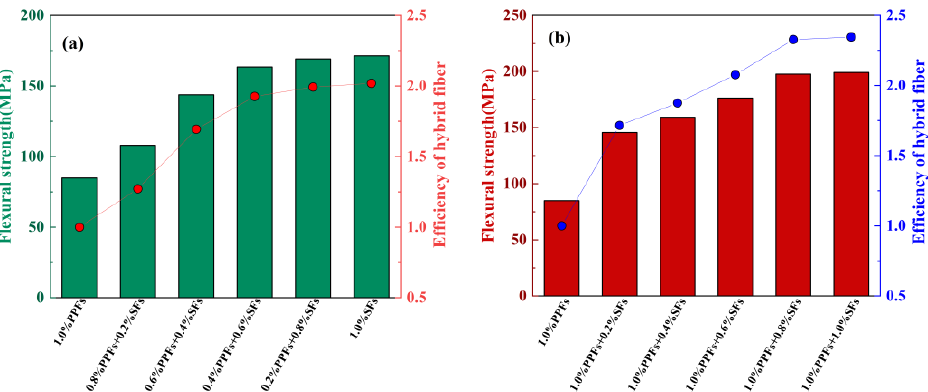
Figure 25. The effect of fiber hybrid effect on flexural strength: ( a ) The replacement type; ( b ) the addition type.